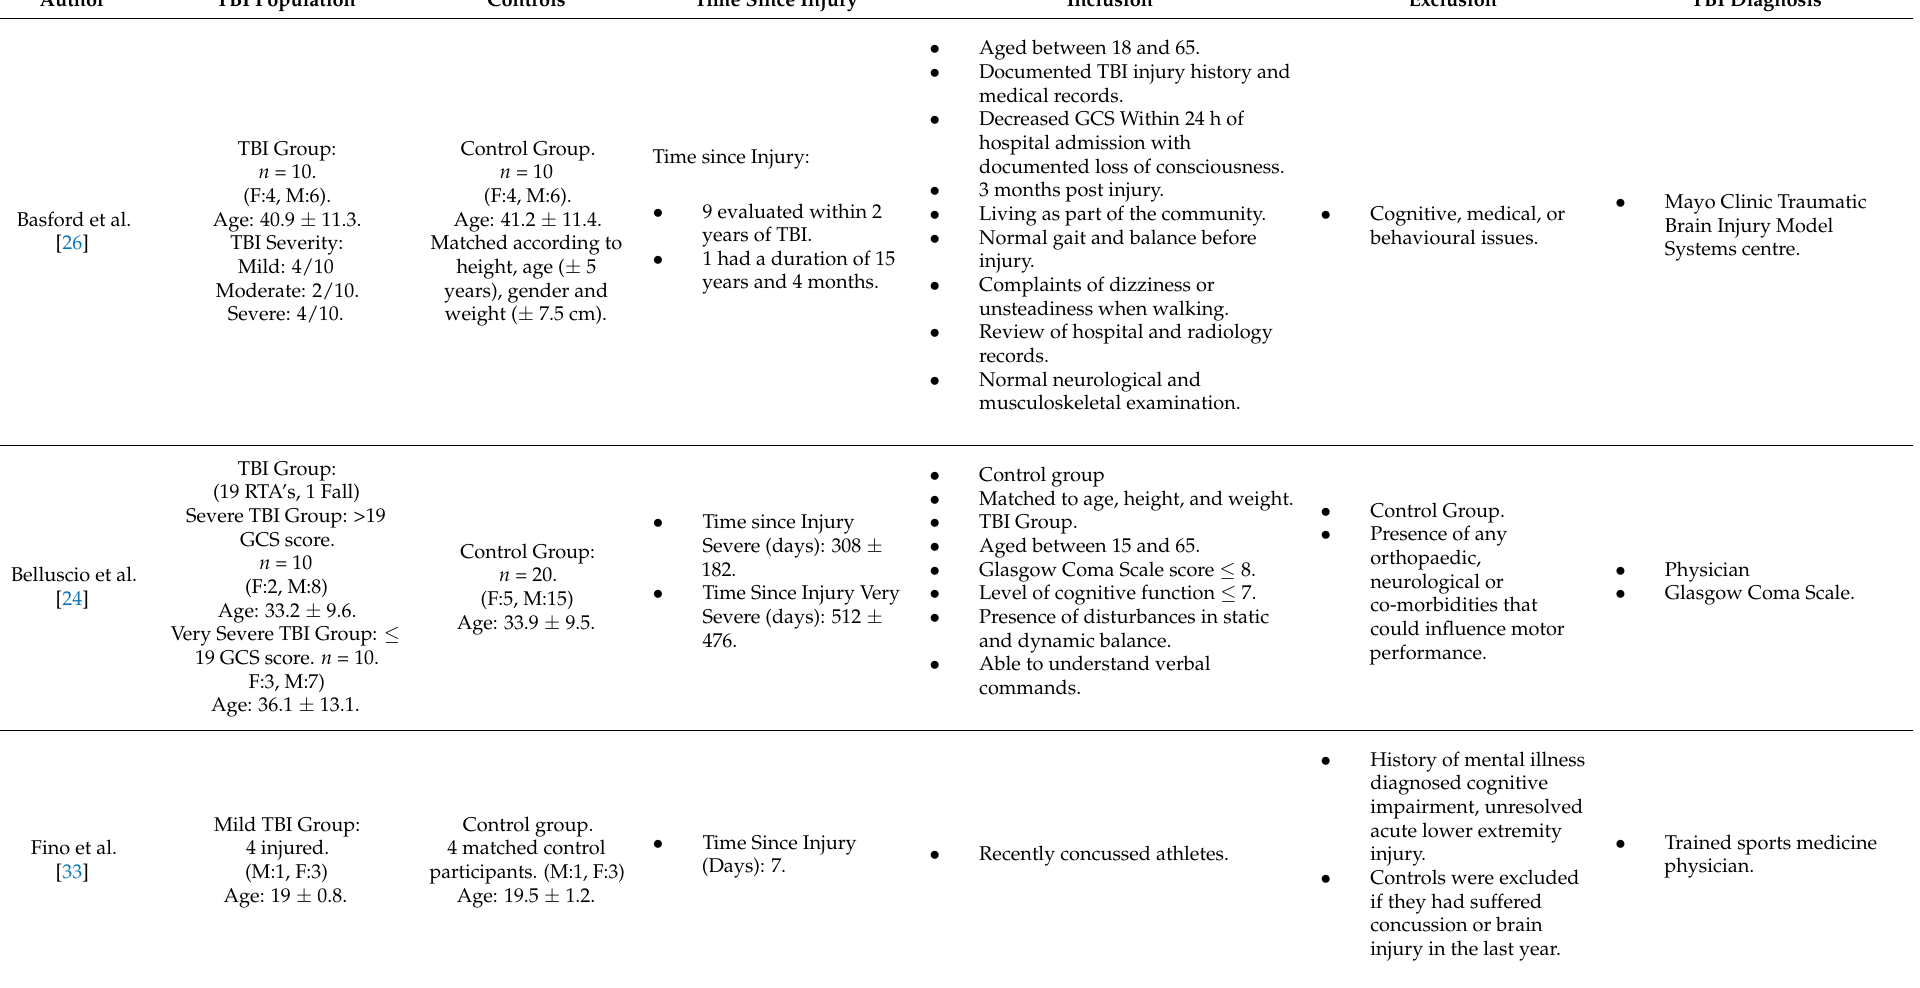
Table 1. Study populations, time since injury, inclusion/exclusion criteria, and TBI